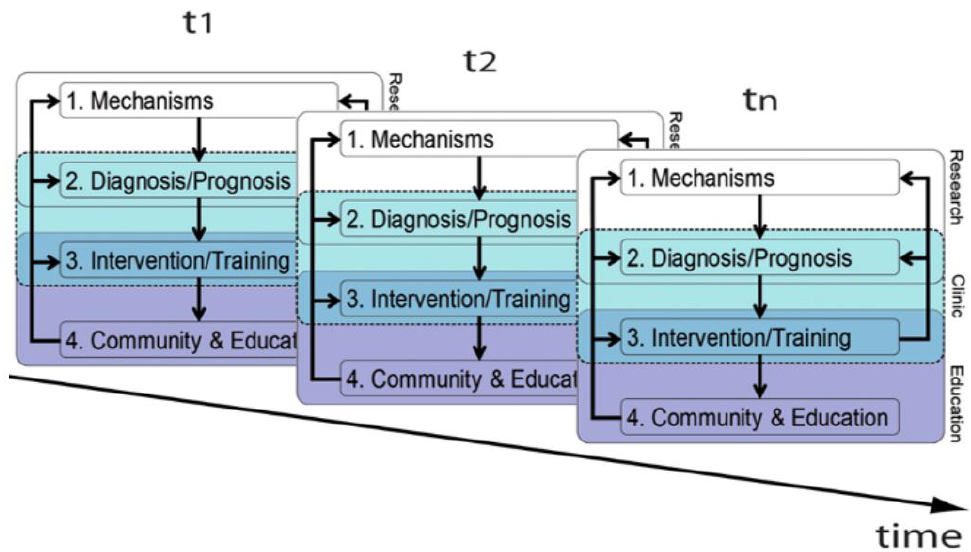
Figure 6. Diagram depicts the theoretical translational framework for the use of educational neuro- science by the educator to develop effective individual educational plans. Results of brain structural and functional testing are offered by clinicians to educators regarding diagnosis and prognosis of the maturing child through the school years. Interpretation of these findings are based on knowl- edge of developmental neuroscience research applied to clinical decision making. Interventional strategies are developed by the interdisciplinary educational team of teachers, psychologists and therapists based on this information at multiple time points. Lessons plans are revised as a function of advancing school grades. These teaching strategies are generally applied across a community’s school system calibrated to resource-availability [66].